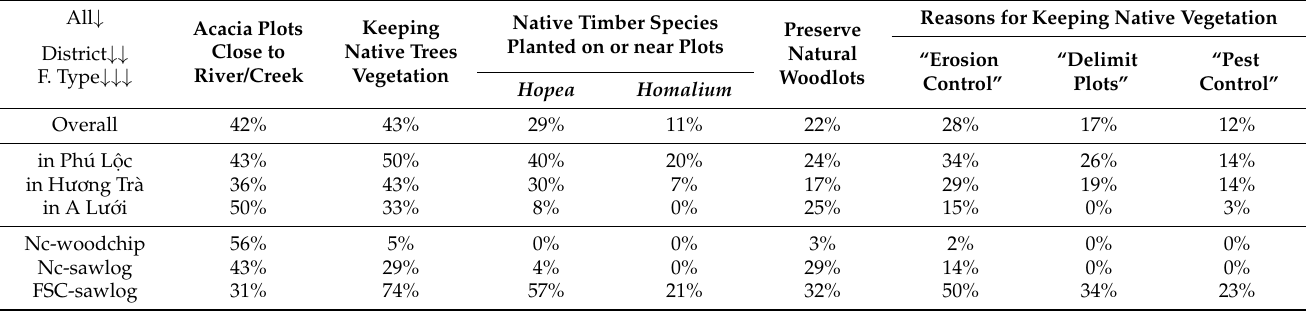
Table 7. Summary of data on native vegetation planting and conservation in and around acacia plantations, showing differences among the three study districts and farmer